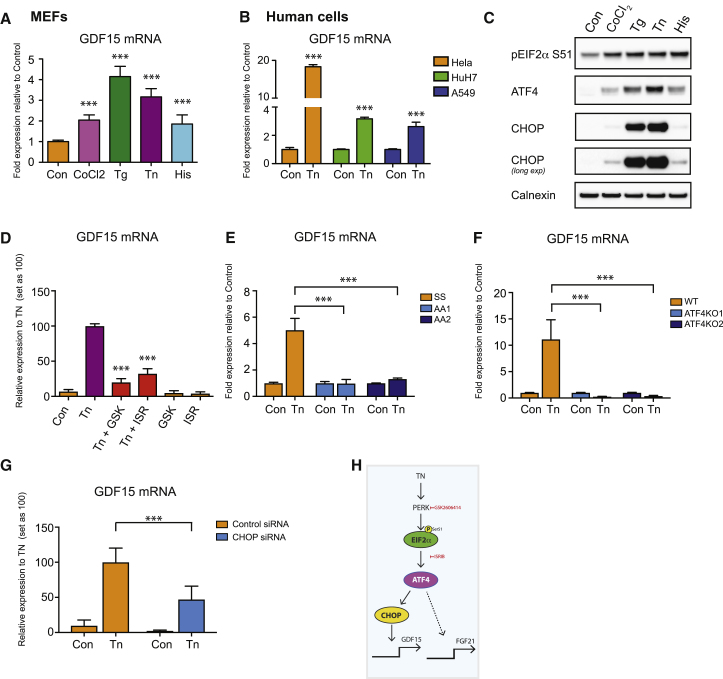
GDF15 Expression Is Regulated by the Cellular ISR Pathway(A and C) GDF15 mRNA expression (A) and immunoblot analysis (C) of ISR components in wild-type (WT) mouse embryonic fibroblasts (MEFs) treated with vehicle control (Con), cobalt chloride (CoCl2, 625 μM), thapsigargin (Tg, 1 μM), tunicamycin (Tn 5 μg/mL), or L-Histidinol (His, 1 mM) for 6 h.(B) GDF15 mRNA expression in human cell lines (HeLA, HuH7, and A549) treated with Tn (5 μg/mL) for 6 h.(D) GDF15 mRNA expression in WT MEFs pre-treated for 1 h either with the PERK inhibitor GSK2606414 (GSK, 200 nM) or eIF2α inhibitor ISRIB (ISR, 100 nM), then co-treated with Tn (5 μg/mL) for a further 6 h.(E–G) GDF15 mRNA expression (E) in EIF2α Ser51 (SS) or phospho mutant (AA) MEFs or (F) in ATF4 wild-type (WT) or ATF4 knockout (KO) MEFs and (G) in control siRNA and CHOP siRNA transfected WT MEFs treated with Tn (5 μg/mL) for 6 h.(H) Diagram outlining pathway by which GDF15 and FGF21 expression is regulated by TN. mRNA expression is presented as fold expression relative to its respective control treatment for each cell type (set at 1) or TN-treated samples (set as 100) with normalization to HPRT gene expression in MEFs and GAPDH in human cells.Data are expressed as mean ± SD from at least three independent experiments. ∗∗∗p < 0.001 versus control (con) for (A) and (B), and versus TN stimulated for (D)–(G) by two-tailed Student’s t test. Blots shown are representative of three independent experiments with Calnexin used as a loading control. See also Figures S3 and S4.